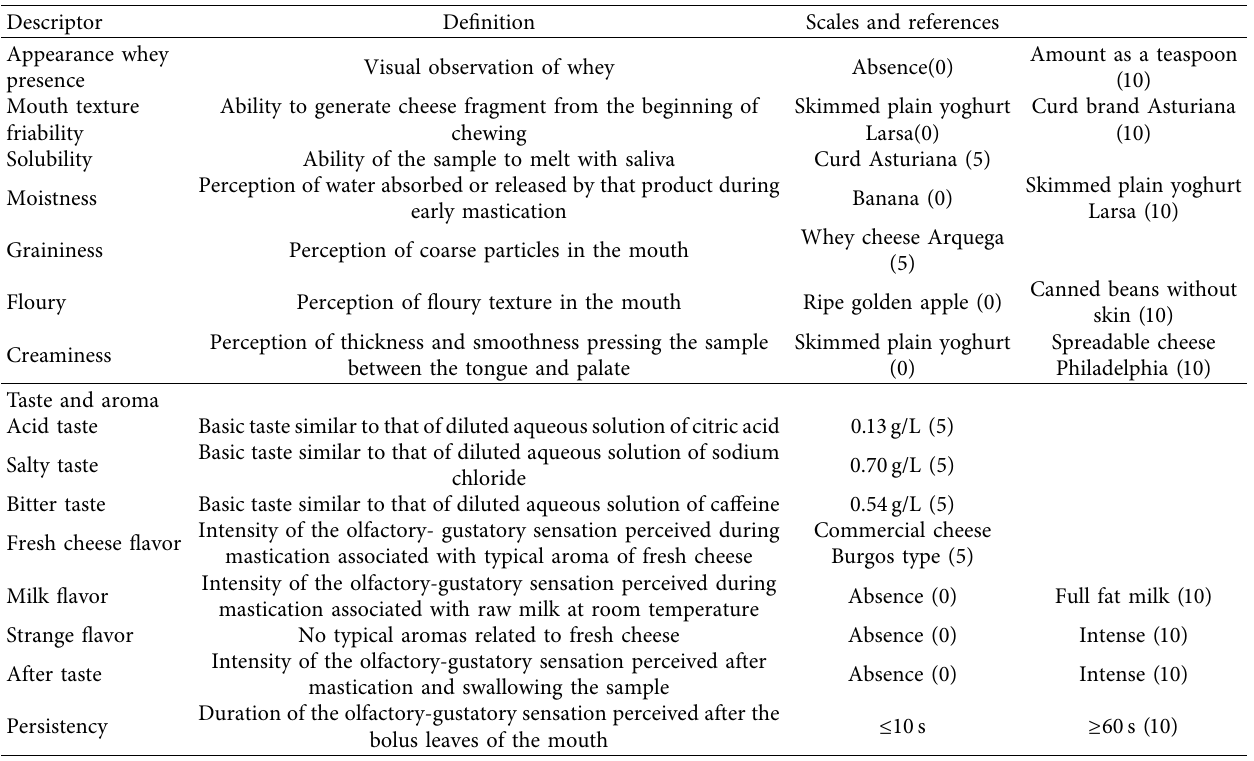
Table 1: Definition, evaluation procedure, scale, and references used for the attribute